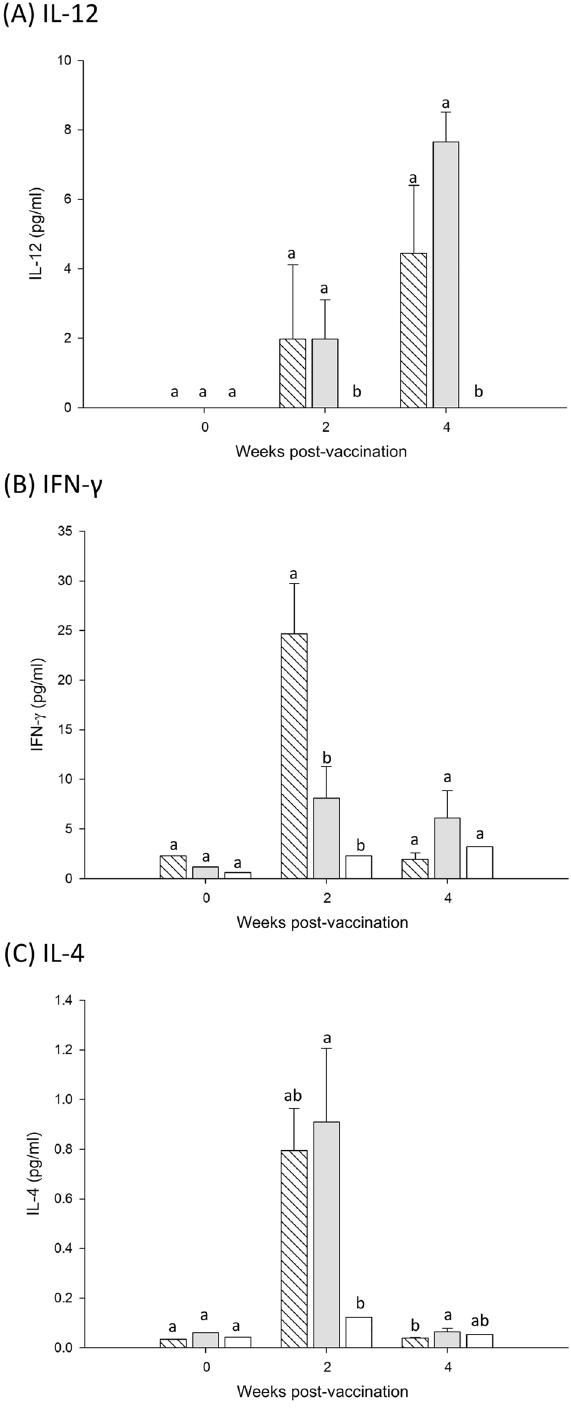
Figure 6. Concentration of cytokines ( A ) IL-12, ( B ) IFN-γ, and ( C ) IL-4 in mice immunized with 5 or 35 μg of truncated E2 glycoprotein or PBS. Data are presented as mean ± standard deviations of the sera concentration of each cytokine determined using commercial ELISA kits. Different letters (a, b, c) on the bar indicate significant ( P < 0.05) between-group differences at the same time point.( ) Group I: 5 μg of truncated E2 glycoprotein;( ) Group II: 35 μg of truncated E2 glycoprotein;( ) Group III: